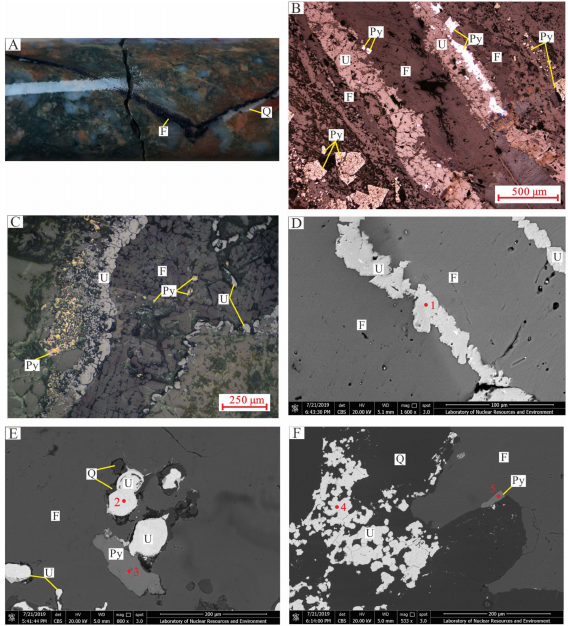
Figure 4. Vein uranium ore with fluorite as the main gangue mineral. ( A ): Purple-black fluorite-type uranium ore veinlets coexisting with quartz. ( B , C ): Center is mainly fluorite (F), with pitchblende (U), fluorite (F), and pyrite (Py) appearing successively on both sides. Pitchblende occurs in the periphery of veins; pyrite (Py) with good crystalline morphology is mainly distributed outside the vein, which is consistent with the distribution trend of vein bodies; and pitchblende and pyrite grow between fluorite grains in the vein body ( C ). ( D ): Pitchblende (U) and fluorite (F) growing alternately in belts. ( E ): Pitchblende (U) and pyrite (Py) co-crystallize between fluorite (F) crystals, and the pitchblende is surrounded by a microcrystalline quartz (Q) film. ( F ): Pitchblende (U) and pyrite (Py) growing between fluorite and quartz crystals. ( B ): 5 × , Reflected-light; ( C ): 10 × , Reflected-light; ( D – F ): SEM images. ( A , B , D , E ) Sample No. M17-1, and ( C , F ) sample No. M17-62. Graph surface digital representation energy-dispersive spectrum measuring point